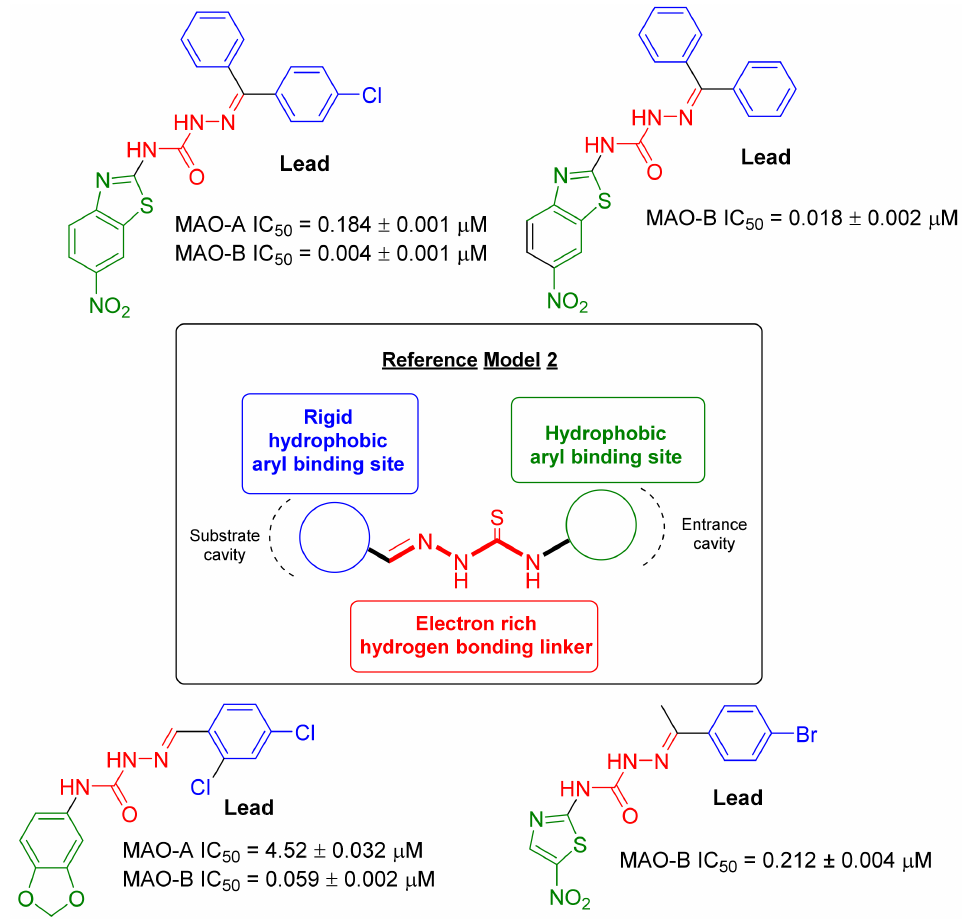
Figure 2. Some novel MAO inhibitor agents and reference model of target